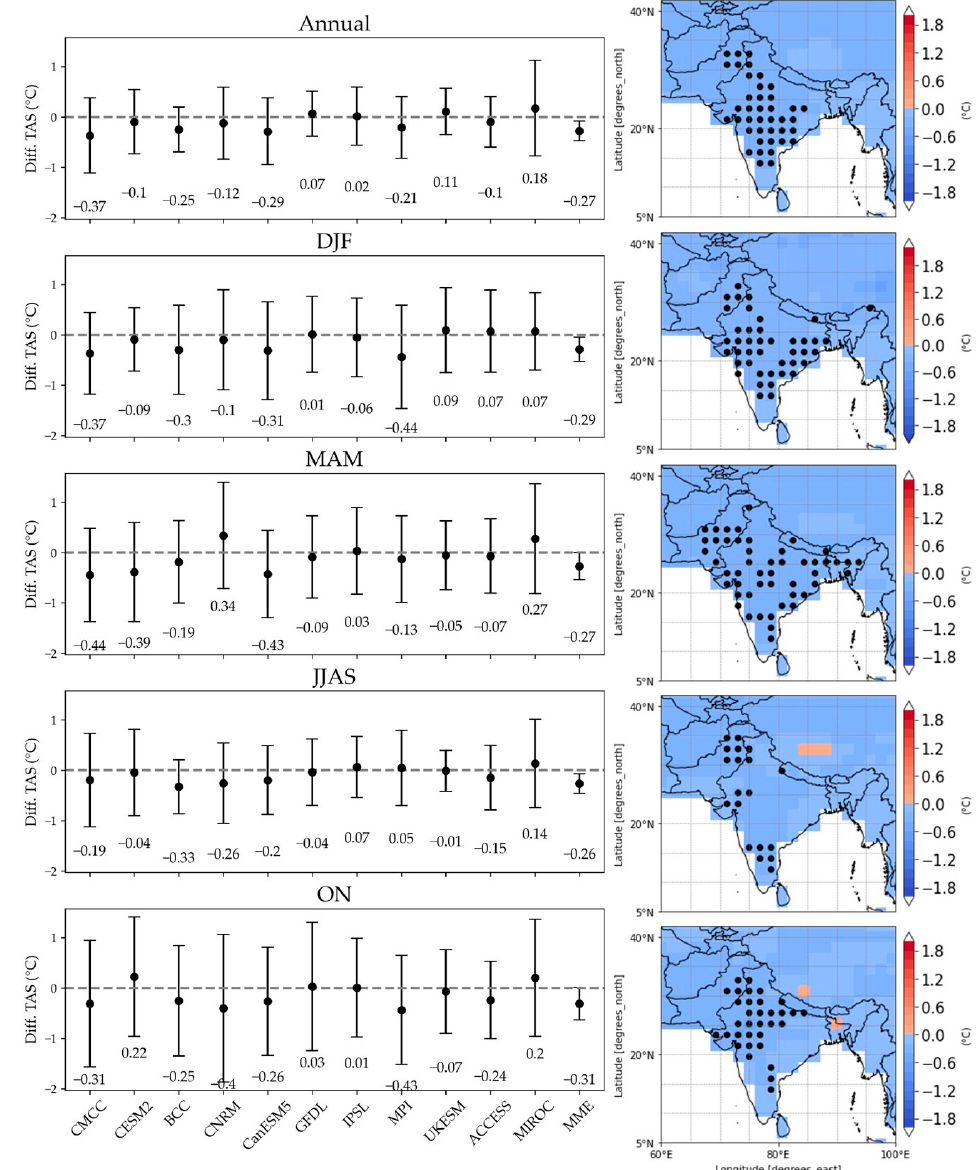
Figure 7. On the right-hand side, the spatial distribution of the multimodel mean changes in TAS ( historical minus hist-noLu ) at annual and seasonal temporal scales. The blue colors illustrate cooling and the robust areas are marked by a black dot. On the left-hand side, the CMIP6-GCMs model spread (standard deviations and model-mean) over robust areas for the respective temporal scale.